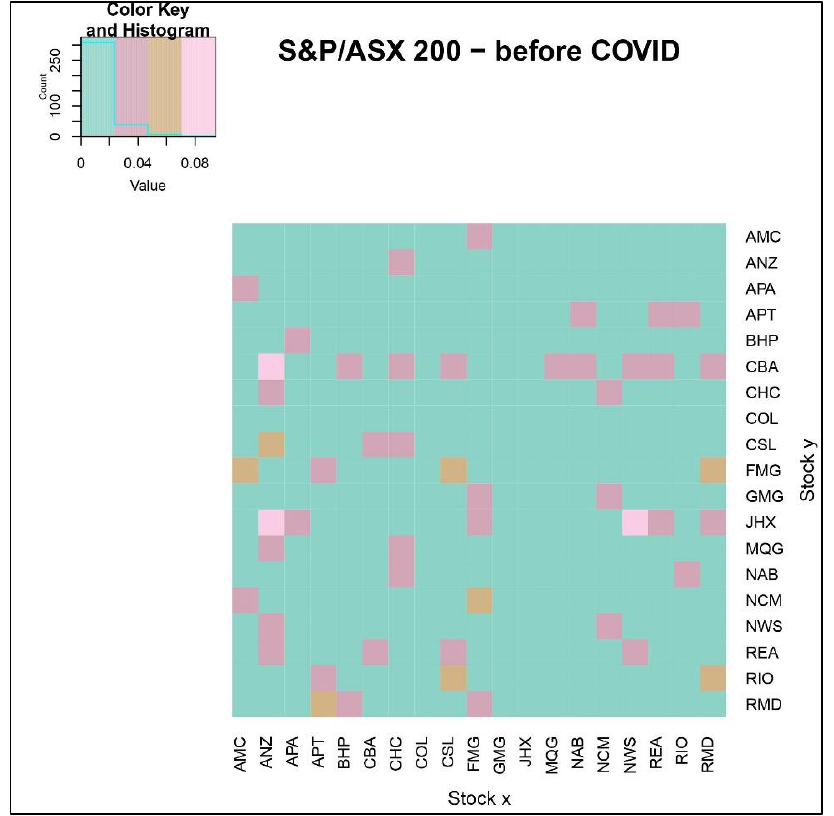
Figure 21. The information flow (effective transfer entropy) from stock y to stock x, for the top companies (by market capitalization) in the S&P ASX market, before the COVID-19 outbreak